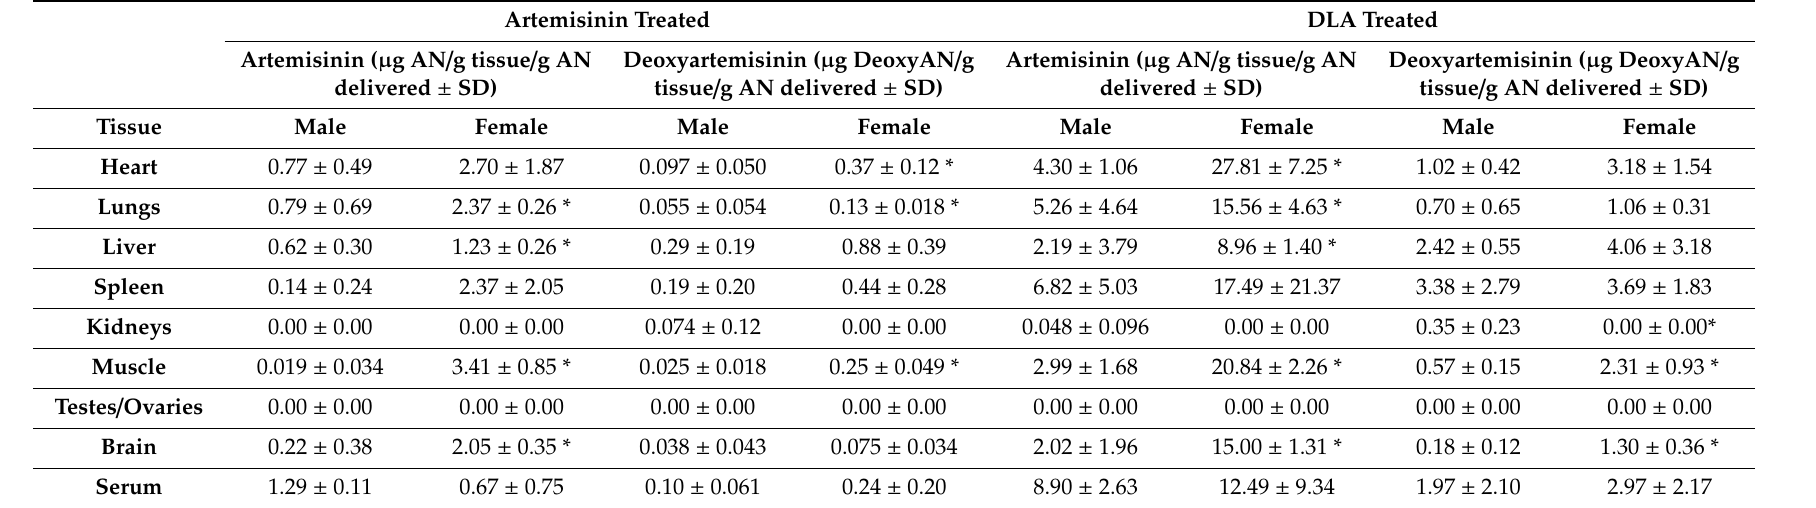
AN, artemisinin; deoxyAN, deoxyartemisinin; SD, standard deviation; n = 3; *, p ≤ 0.05 when compared to opposite